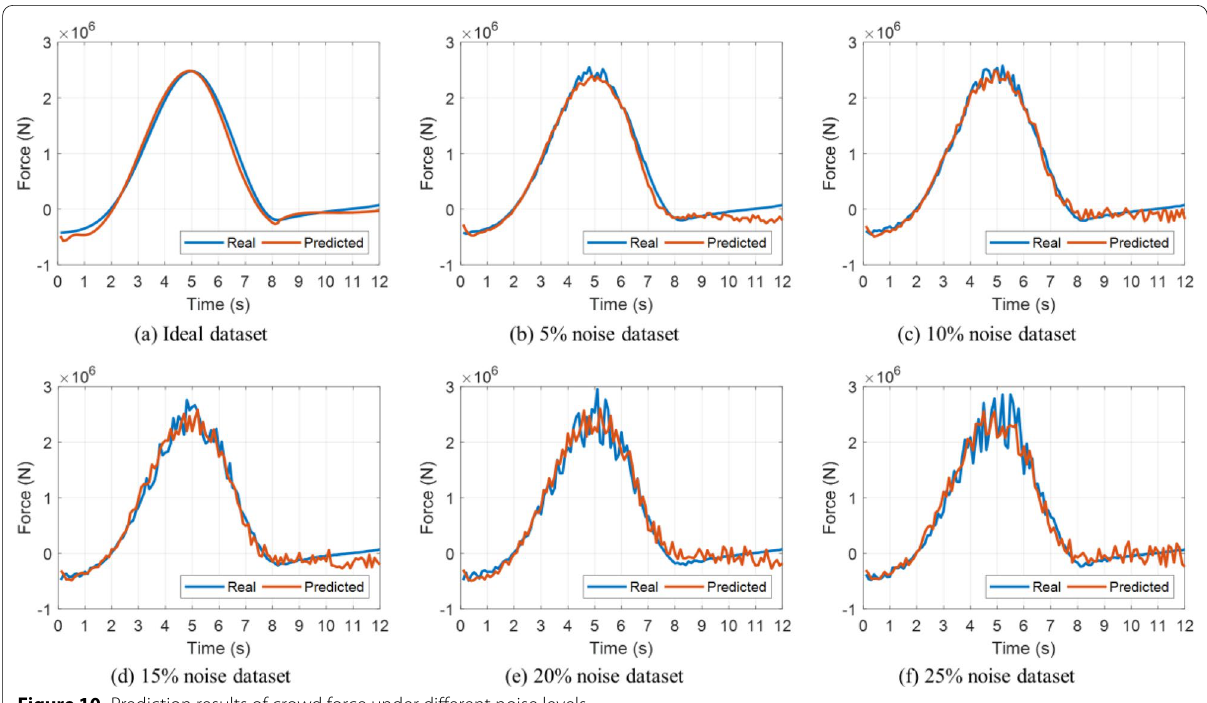
Figure 10 Prediction results of crowd force under different noise levels